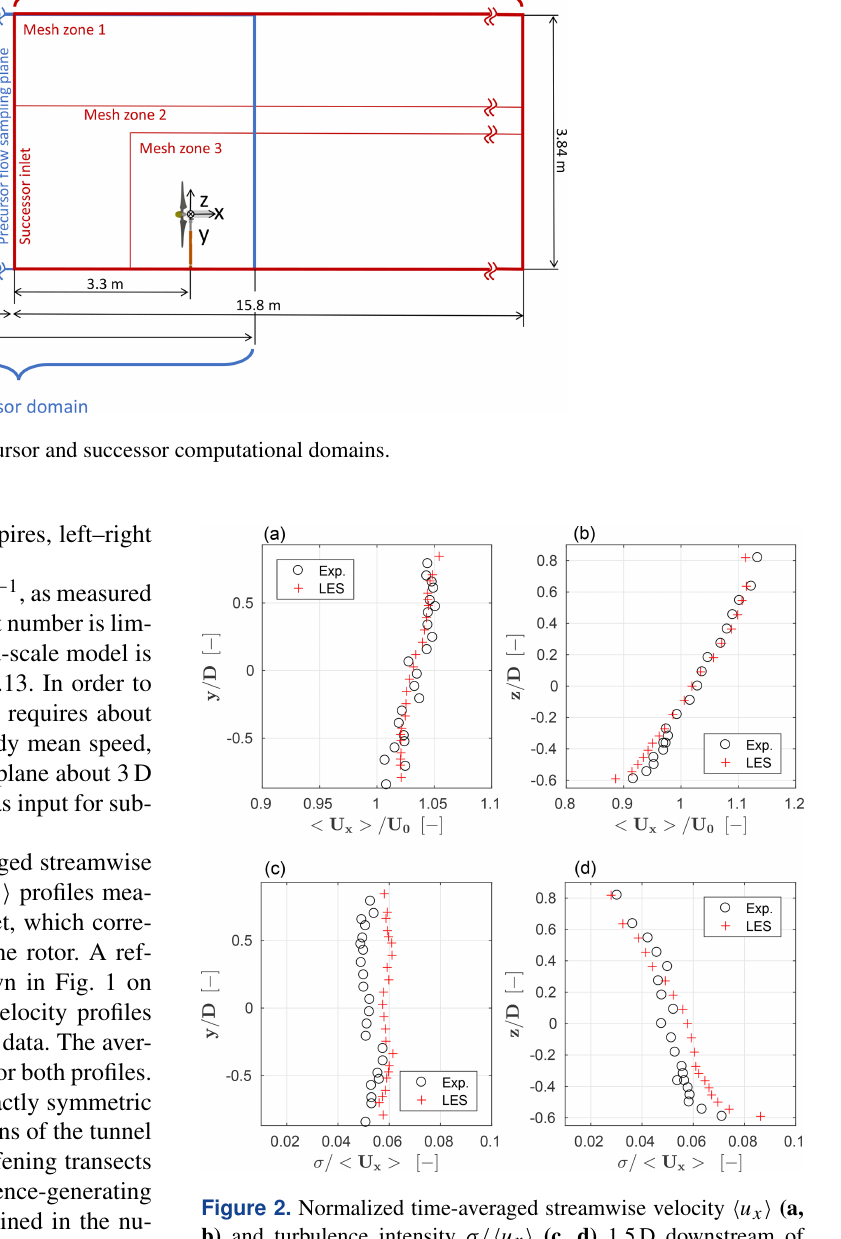
Figure 2. Normalized time-averaged streamwise velocity (cid:104) u x (cid:105) (a, b) and turbulence intensity σ/ (cid:104) u x (cid:105) (c, d) 1.5D downstream of the rotor. Left column: hub-height horizontal profile; right column: hub-centered vertical profile. Red + symbols: numerical results; black ◦ symbols: experimental